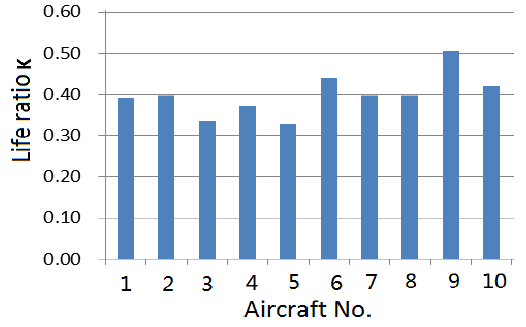
Figure 6. Fatigue life consumption for different aircraft in fleet.